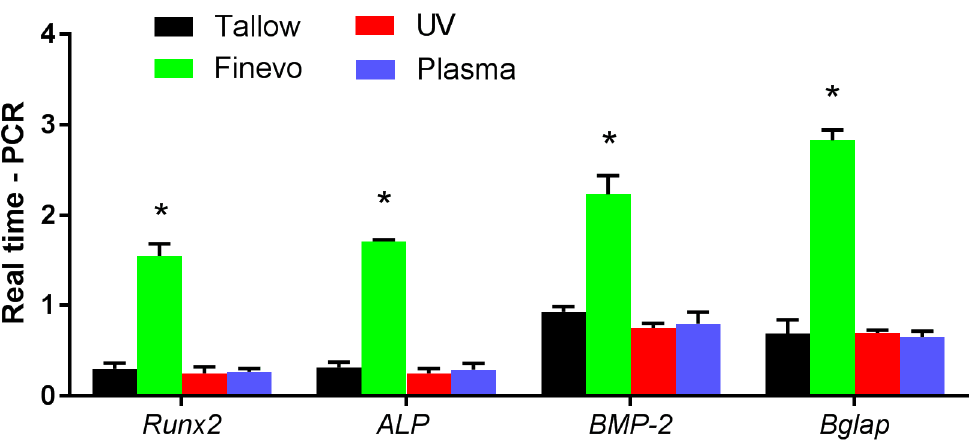
Figure 9. The expression level of osteogenesis-related genes evaluated by quantitative RT-PCR. The cells on Finevo-Ti showed higher mRNA levels of ALP and Runx2 at 3 and 7 d, and higher mRNA levels of BMP-2 and Bglap at 14 and 21 days than the cells on other groups. The mRNA levels of ALP and Runx2 of Tallow-Ti, UV-Ti and Plasma-Ti at 3 and 7 days decreased in this sequence. The trend of mRNA levels of BMP-2 and Bglap at 14 and 21 days in the case of Tallow-Ti, UV-Ti and Plasma-Ti was similar to that on 3 and 7 d. Black: Tallow-Ti, Green: Finevo-Ti, Red: Plasma-Ti, Blue: UV-Ti. (* p <0.05)